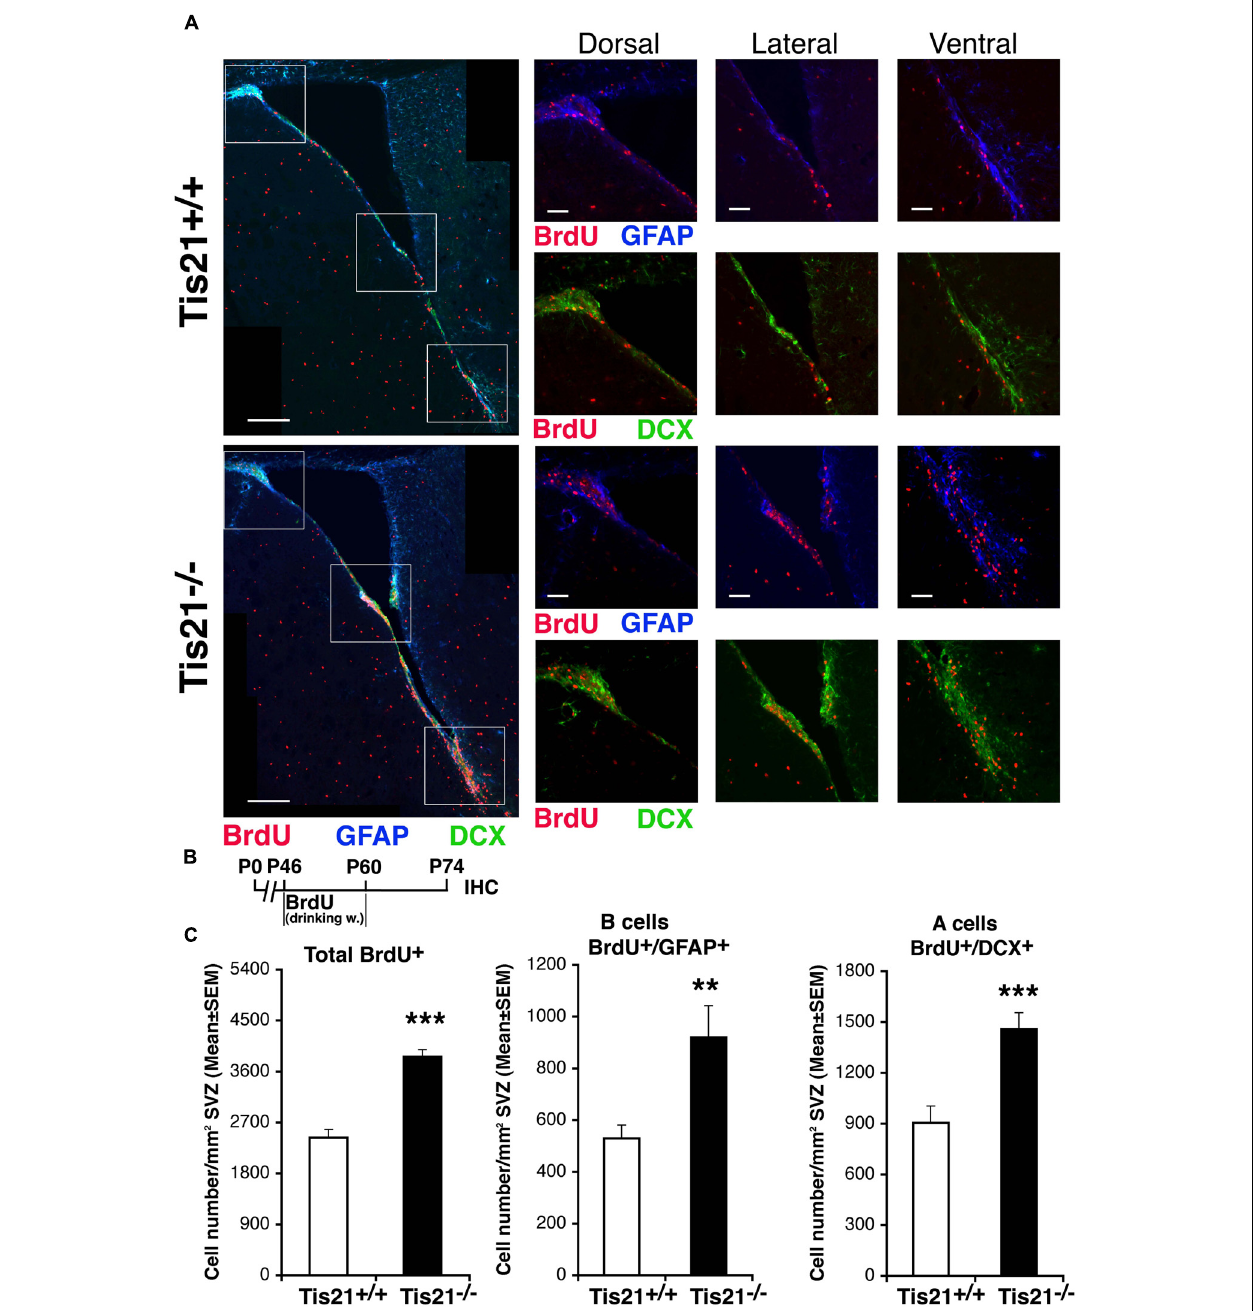
FIGURE 4 | Increase of slow-dividing stem cells and of neuroblasts that have exited the cell cycle in adult SVZ of Tis21 knockout mice. (A) Representative confocal images of coronal sections of the SVZ in P74 Tis21 + / + and Tis21 − / − mice, with higher magnification views of dorsal, lateral and ventral areas (white boxes). Shown are slowly dividing B stem cells (BrdU + /GFAP + ) and BrdU-retaining A neuroblasts (BrdU + /DCX + ). Scale bars, 200 and 50 μ m (enlargement). (B) Scheme of BrdU treatment, added to